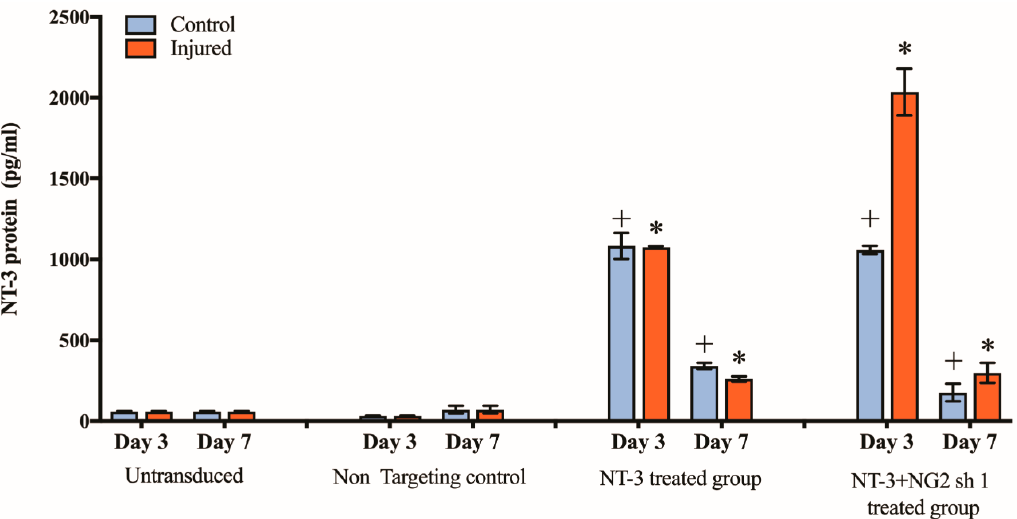
Figure 6. NT-3 protein is released into conditioned media after Lenti-NT-3 transduction of spinal cord slices. Graph shows the NT-3 protein concentration (in pg/mL) measured in the media harvested from control and injured, untransduced and transduced spinal cord slices. The culture media were harvested at days 3 and 7 and untransduced slices were used as a control. Mean ± SEM, + p ≤ 0.001 significant increase from day 3 and 7 untransduced control group, * p ≤ 0.001 significant increase from day 3 and 7 untransduced injured group. The mean differences were analysed using two-way ANOVA. n = 3 litters (12 pups per litter) which relates to six slices per control group per time-point and nine slices per injured group per time-point for each litter.